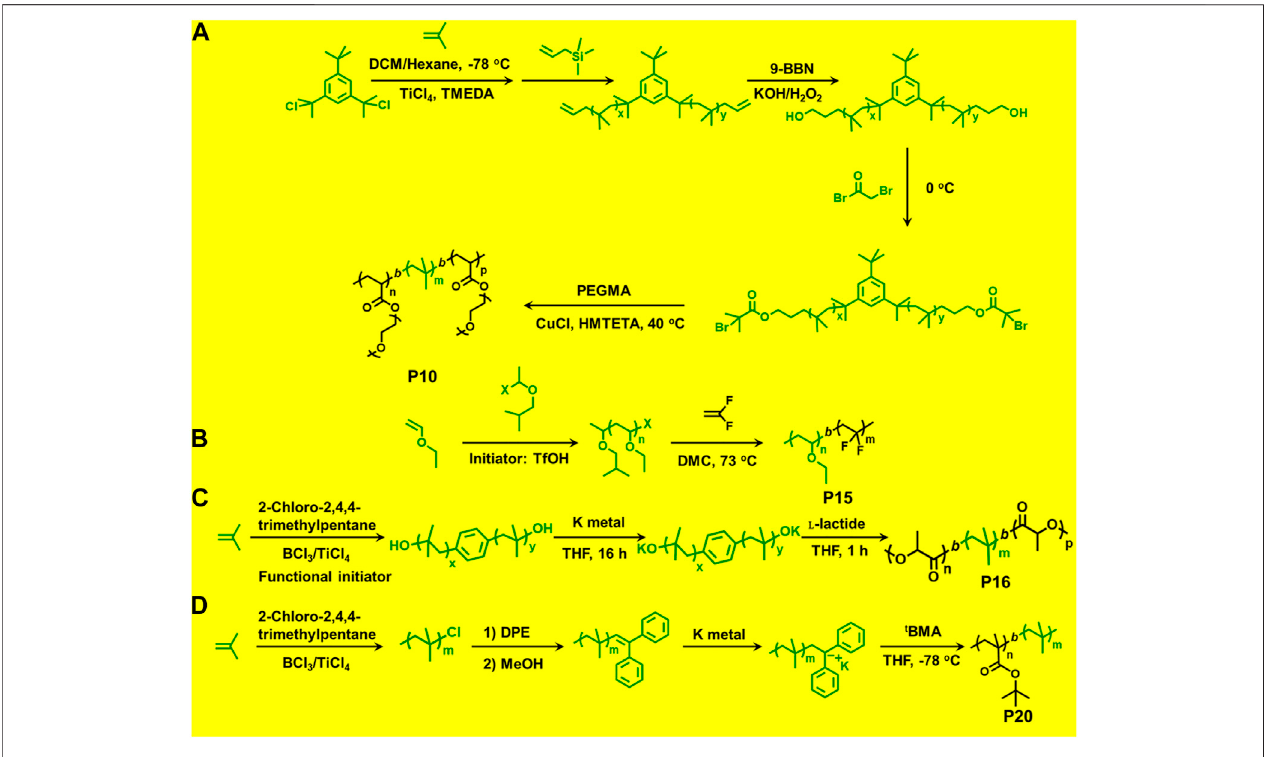
FIGURE5|(A) Blockcopolymersynthesis via combinationoflivingcationicpolymerizationandatomtransferradicalpolymerization. (B) Blockcopolymersynthesis via combination of living cationic polymerization and radical polymerization. (C) Block copolymer synthesis via combination of living cationic polymerization and ring-opening polymerization. (D) Block copolymer synthesis via combination of living cationic polymerization and anionic polymerization.